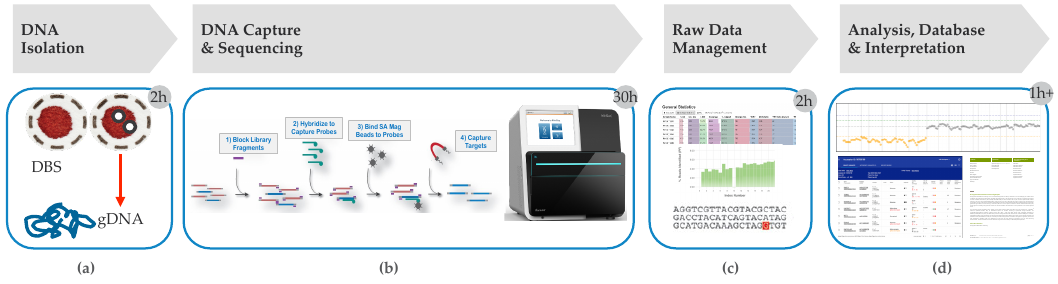
Figure 1. Hybrid Capture-Sequencing tNGS Workflow. Many components of the workflow may be automated: ( a ) DNA Isolation—This step in the workflow may be performed with two 3.2 mm DBS punches, takes 2 h (h) to perform and is an essential requirement of second tier testing as most tNGS protocols call for 2–10 mL of blood; ( b ) DNA hybrid Capture and Sequencing—DNA capture requires library preparation and bait based DNA hybridization-based capture of target regions, which is followed by DNA sequencing (Illumina MiniSeq). ( c ) Raw data management—Involves moving data across secure compliant environments for storage, processing and linking into databases; ( d ) Analysis, database and interpretation—Involves analysis for single nucleotide variants and copy number variant callers, comparative analysis with other database annotations, interpretation and reporting. This overall process takes ~35 h. Adapted from Bhattacharjee et al.